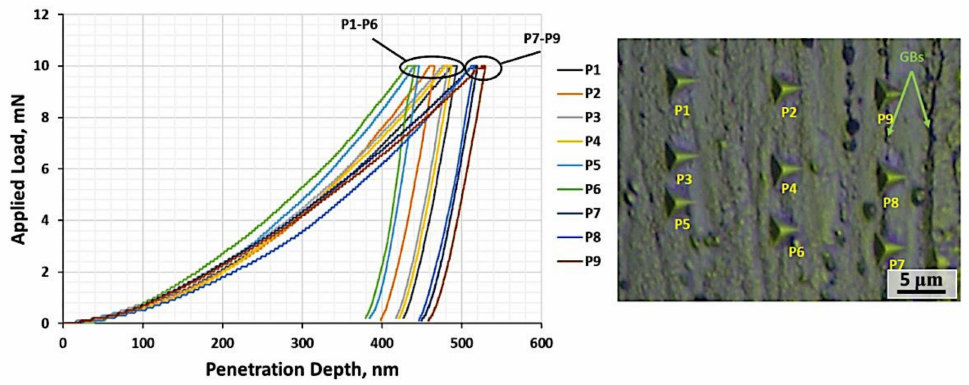
Figure 8. Nanoindentation measurements conducted focusing on the sample aged at 105 ◦ C under 200 MPa for 15 h at various points (P). Locations of points are displayed on the right (see text for